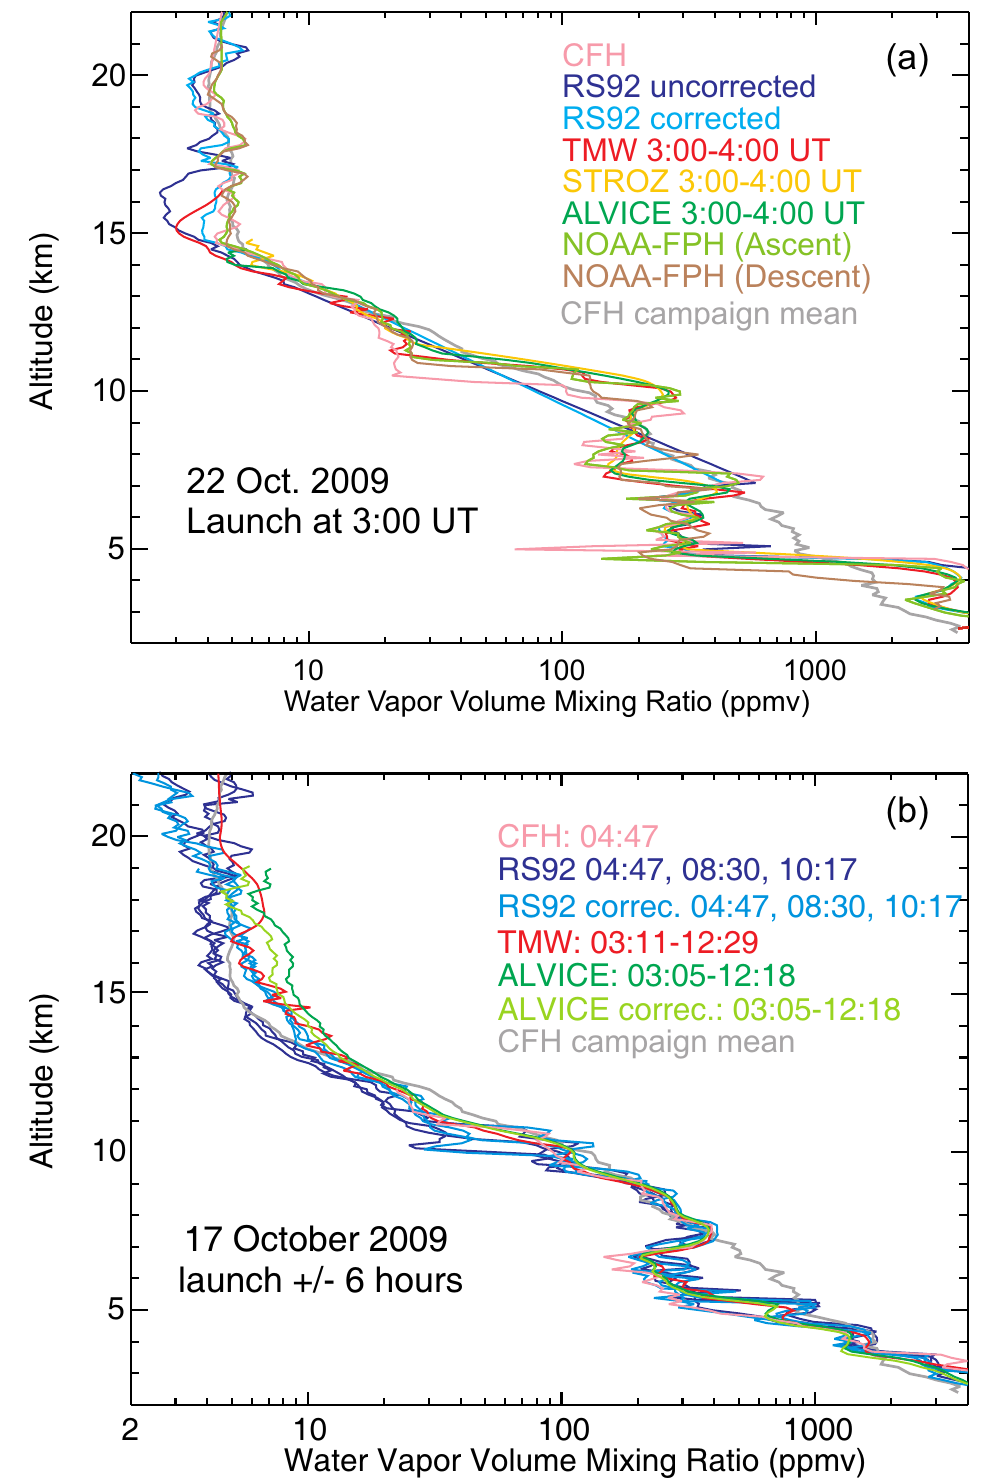
Fig. 5a and b. Balloon-borne and lidar water vapor profiles measured on various campaign nights (with various coincidence criteria apply- ing). Top (a) : simultaneous, lidar integrated for one hour, i.e., from launch time to one-hour after launch. Bottom (b) : lidar integrated for several hours with a ± 6h coincidence criterion with balloon measurements. See text for